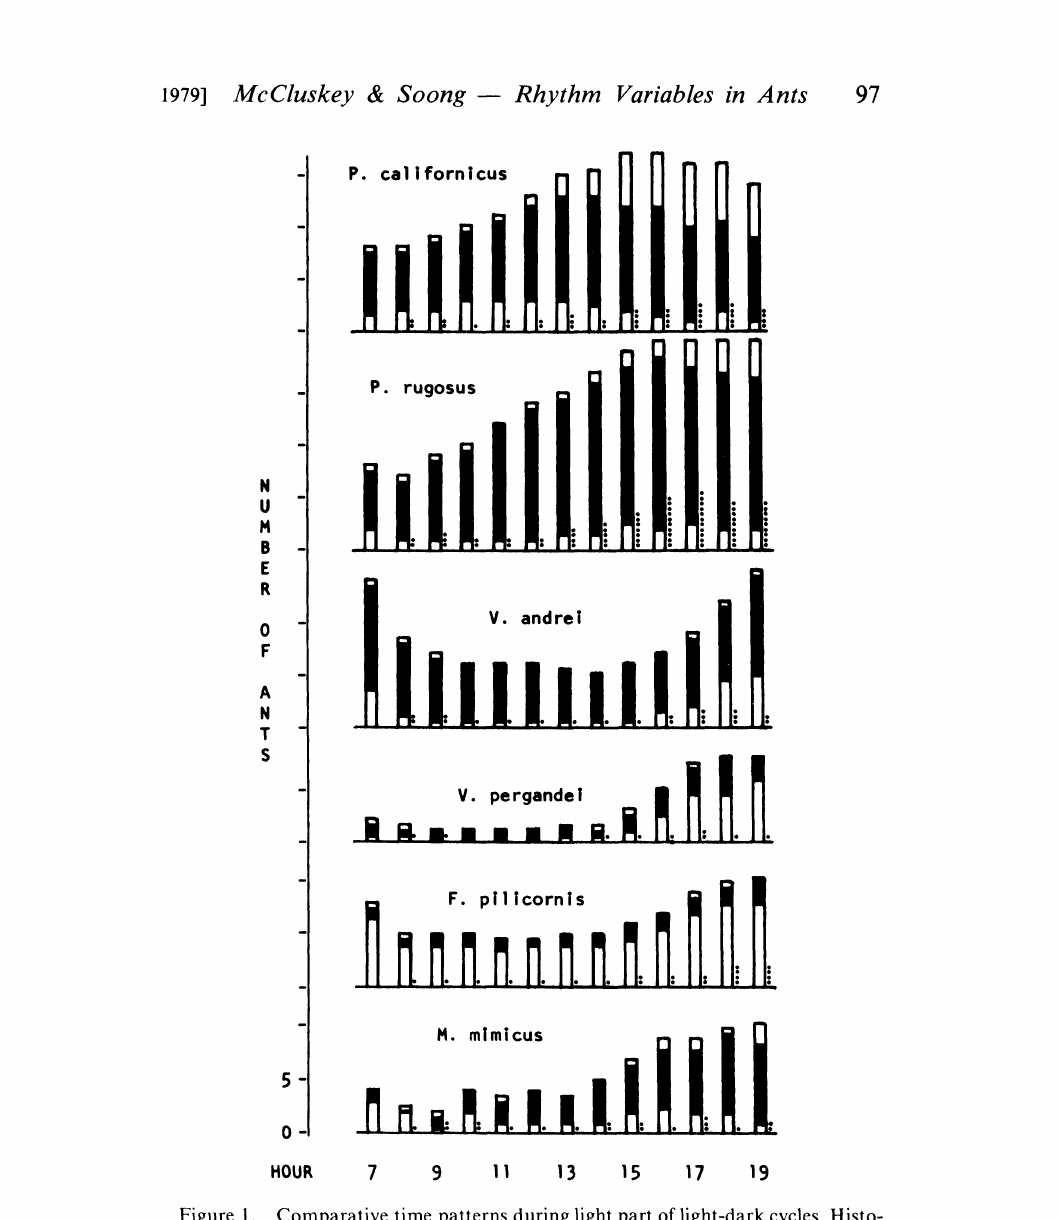
Figure 1. Comparative time patterns during light part of light-dark cycles. Histo- grams based on raw counts averaged over the 3 days (May 27-29) and 5 replicate nests (1 nest for M. mimicus) for each species. Each bar represents total number of ants out at a given observation: bottom part, tube count; middle (shaded), warm half of arena; top, hot half of arena. Dotted line to right of bar represents number active of total number out (omitted for